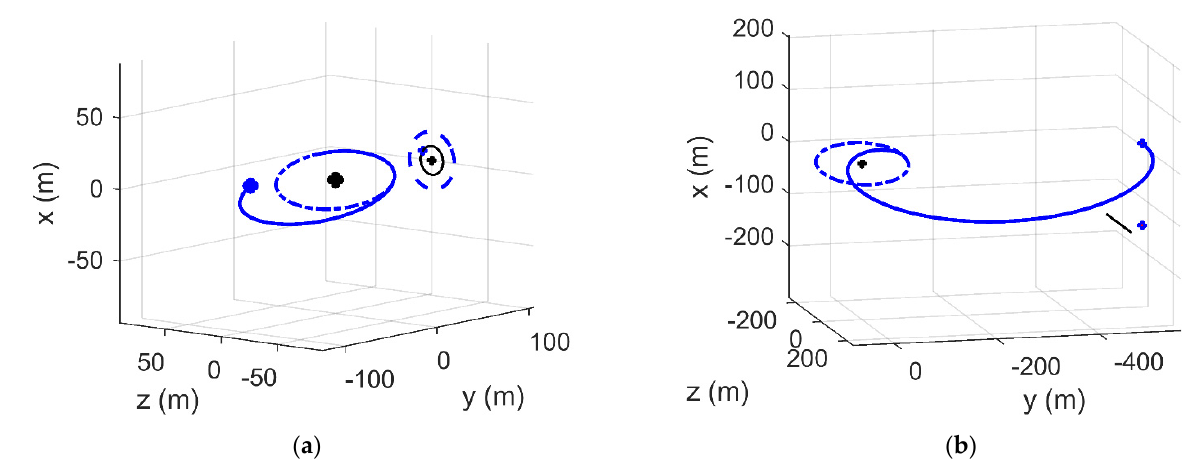
Figure 4. Maneuvers for formation maintenance. ( a ) The reconfiguration is triggered by the deputy trespassing a 10 m safety tube centered around the chief (projected in black solid lines on the xz plane); ( b ) the reconfiguration is caused by the deputy exceeding a 500 m along-track separation (projected in black solid line on the yz